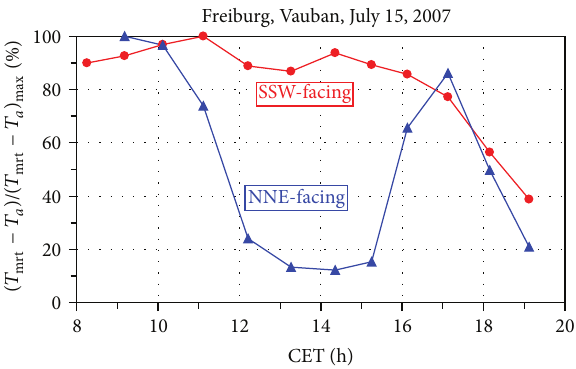
Figure 13: 1h mean values of differences Δ of the sums of short- ) and long-wave radiant flux wave radiant flux densities ( 𝐾 ∗ abs ) from the three-dimensional environment absorbed densities ( 𝐿 ∗ (𝑇 − 𝑇 ) abs 𝑎 max = mrt by the human-biometeorological reference person between the ∘ C) − 𝑇 ) 𝑎 max = 33.3 mrt shaded NNE- and sunny SSW-facing sidewalk of a WNW-ESE street canyon, “Vauban” quarter in Freiburg during typical Central European summer day.